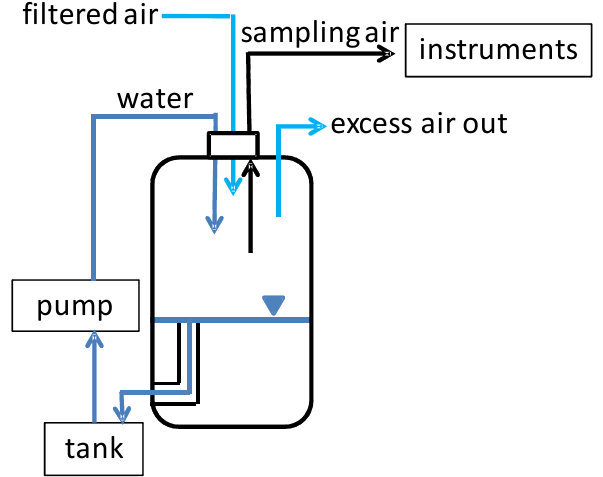
Fig. 2. A schematic picture of the bubble bursting experimental setup (Z´abori et al., 2012a). The tank was used as a buffer to recir- culate the sea water sample trough the PET bottle, where sea spray aerosols were produced by an impinging water jet. Darker blue lines represent water, and the triangle symbol indicates the water surface in the